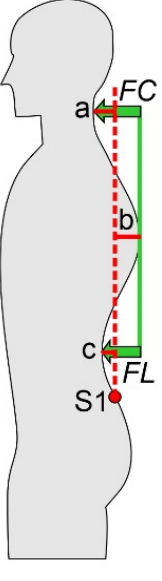
Figure 1. Red lines: horizontal distances of the 3 vertices to the perpendicular (dotted red line) through the first sacral vertebra (S1). Green arrows: flèche cervicale (FC) and flèche lombaire (FL). FC, FL, and KI were additionally calculated as percentages of trunk height (perpendic- ular distance between C7 and S1), denoted as FC%, FL%, and